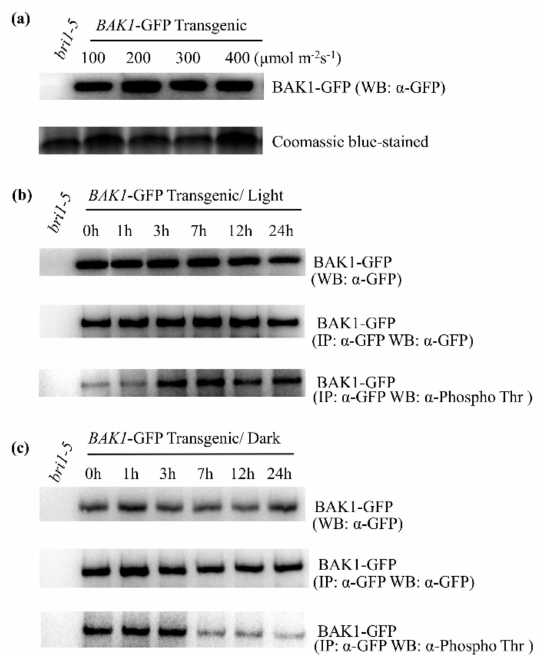
Figure 2. High light can enhance phosphorylation of BAK1 protein in vivo. ( a ) Western blotting analysis on BAK1-GFP- ox transgenic plants indicates similar accumulation levels of BAK1 protein when plants were grown under di ff erent light intensities. Coomassie blue staining indicates equal protein loading. The experiments were repeated three times. ( b , c ) The phosphorylation level of BAK1-GFP protein in BAK1-GFP- ox transgenic plants in response to high light treatment. ( b ) or darkness ( c ). The BAK1-GFP protein was immunoprecipitated from BAK1-GFP- ox transgenic plants or bri1-5 control plants with anti-GFP antibody and protein A beads, followed by Western blotting analysis using anti-Phospho Thr antibody to detect the phosphorylation of BAK1-GFP. Phosphorylation of Thr residues in BAK1-GFP can be enhanced by high light treatment but attenuated dark treatment. The experiments were repeated three